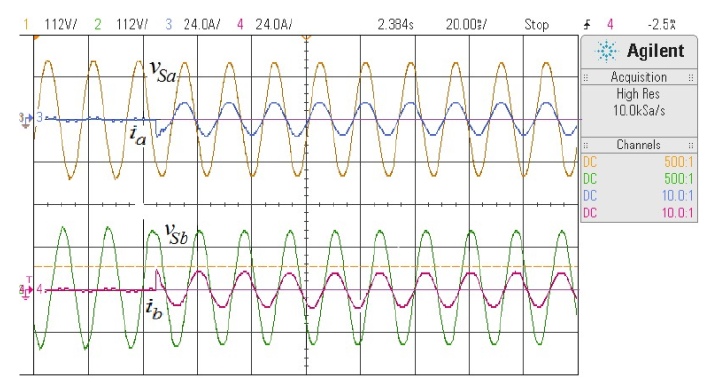
Figure 18. (20 ms/div). Grid voltage (2 V/div) and phase-current (1 A/div) at high-load, f C = 24 kHz. Phase A.